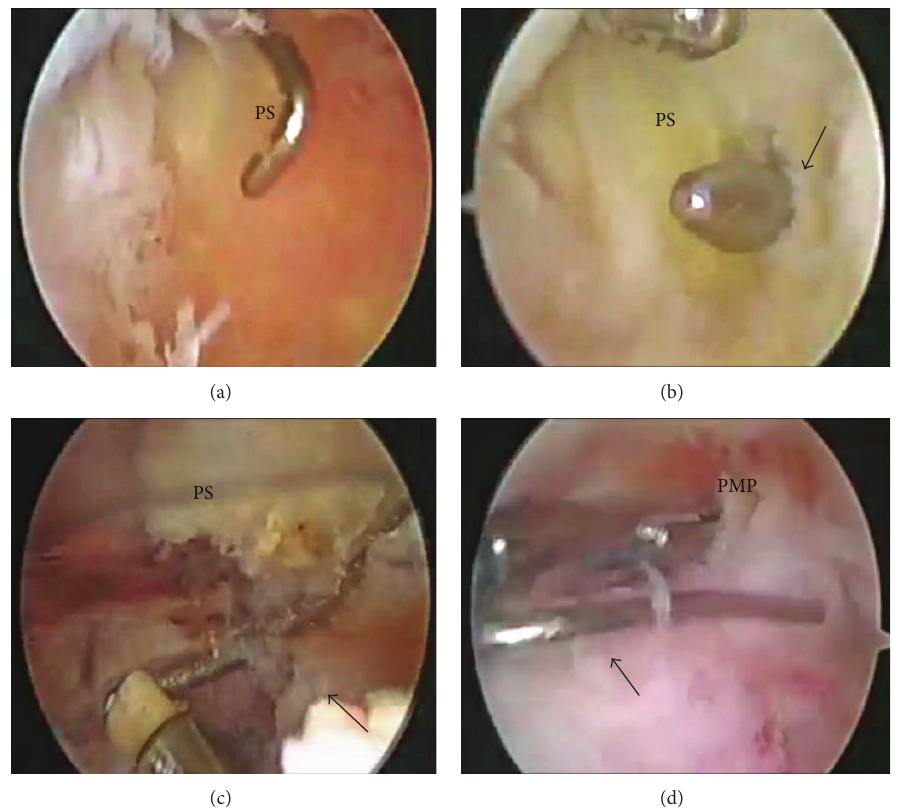
Figure 5: (a) Arthroscopic view from the posteromedial portal shows the palpation of the posterior septum (PS) by an arthroscopic probe through the anteromedial portal. (b) Arthroscopic view from the posteromedial portal shows a small hole (the posterior transseptal portal) (arrow) made at the central portion of posterior septum (PS) behind the PCL. (c) The broken wire (arrow) embedded in the posterior septum (PS) was exposed by enlarging the transseptal portal. (d) Arthroscopic view from the anteromedial portal shows the removal of the broken wire (arrow) through the posteromedial portal (PMP).